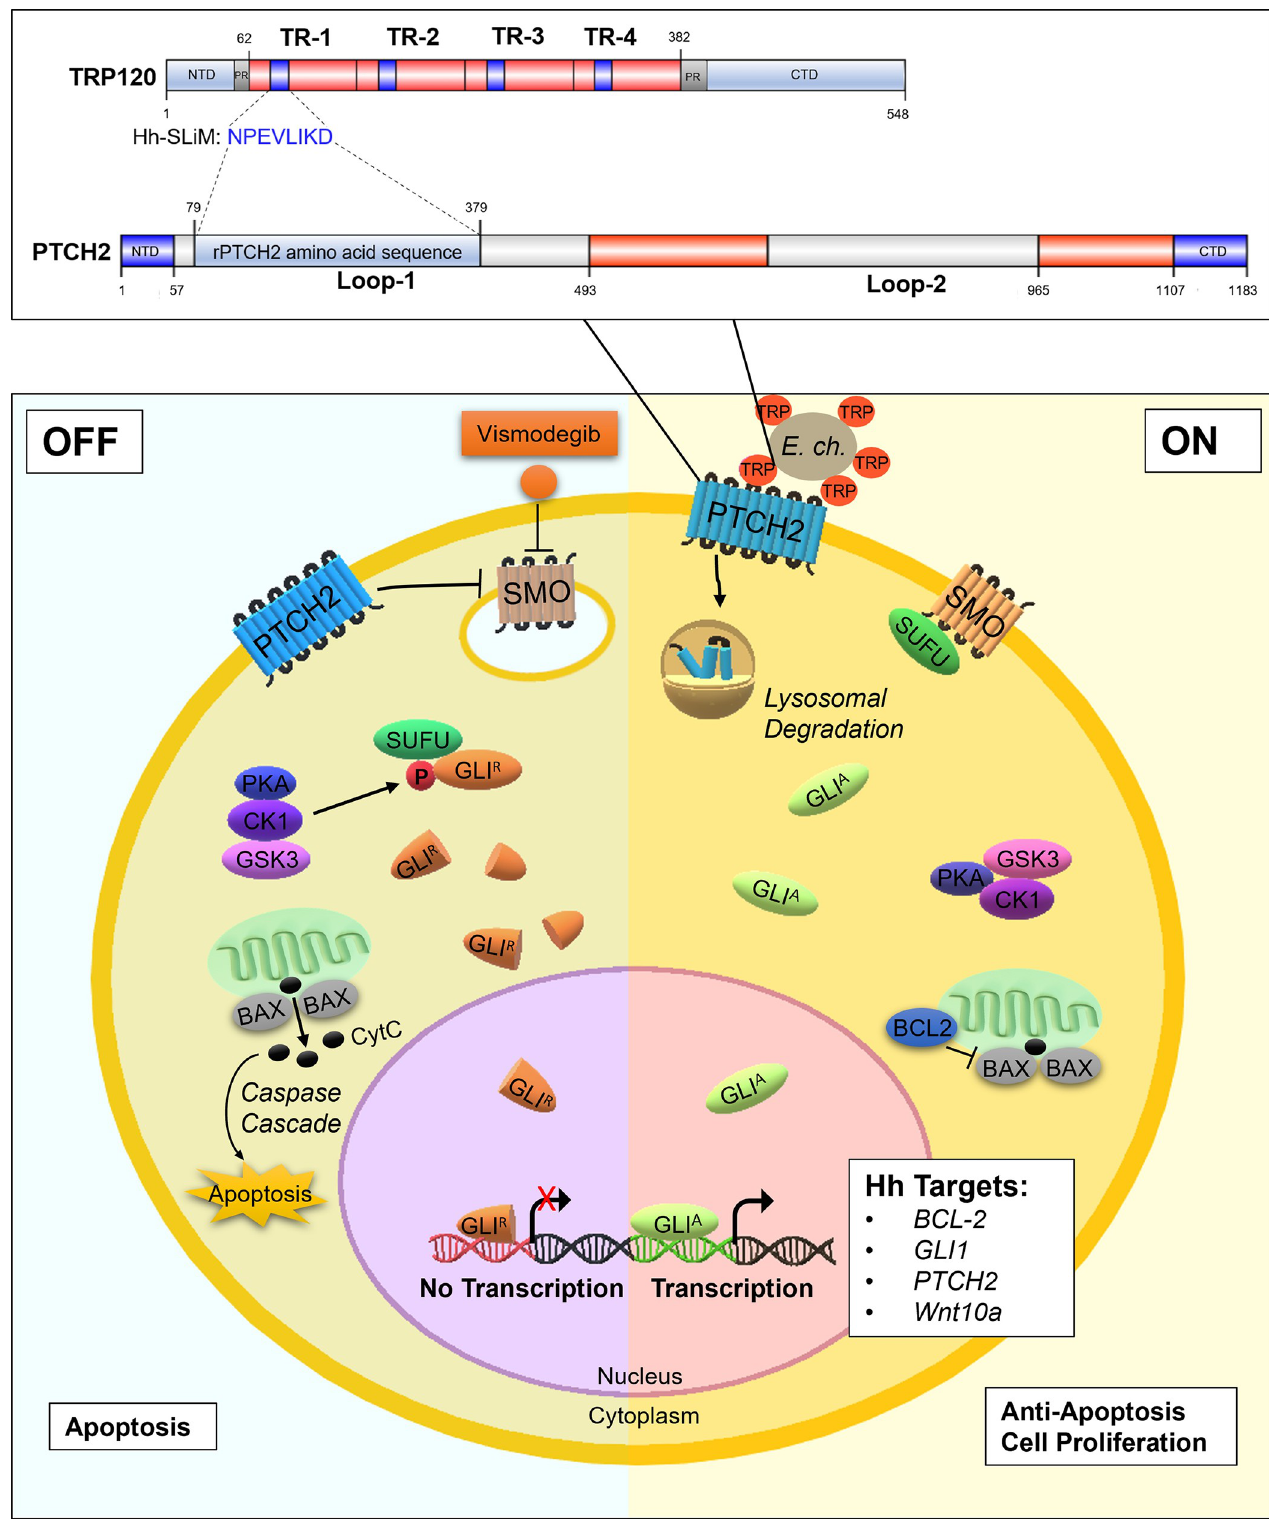
Fig 13. Model of E . chaffeensis TRP120 SLiM mimetic activation of Hh signaling, downstream GLI-1 upregulation and apoptosis inhibition. When Hh signaling is off, GLI-1 is negatively regulated by SUFU, which leads to GLI-1 phosphorylation and truncation. Truncated GLI-1 (GLI R ) translocates to